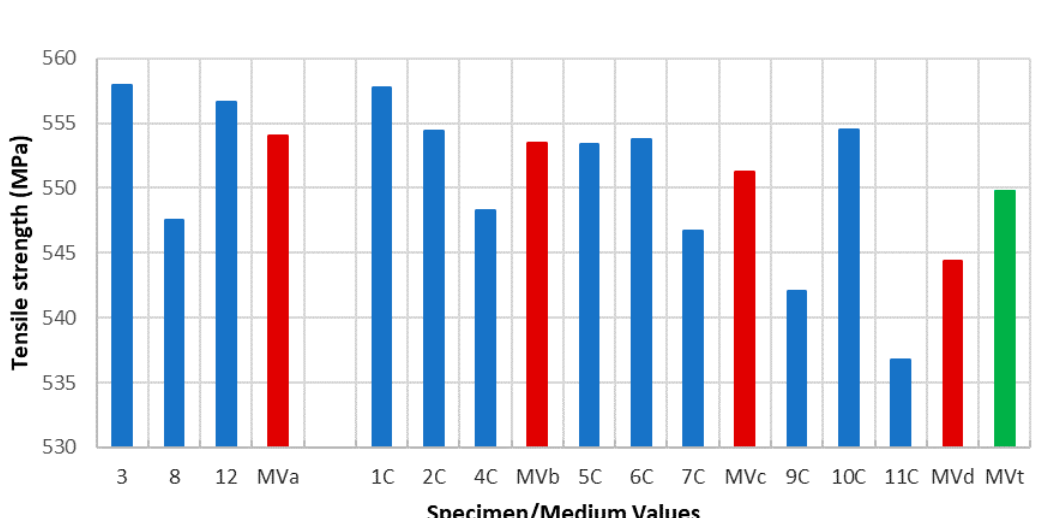
Figure 7. Tensile strength vs. specimen and medium values.